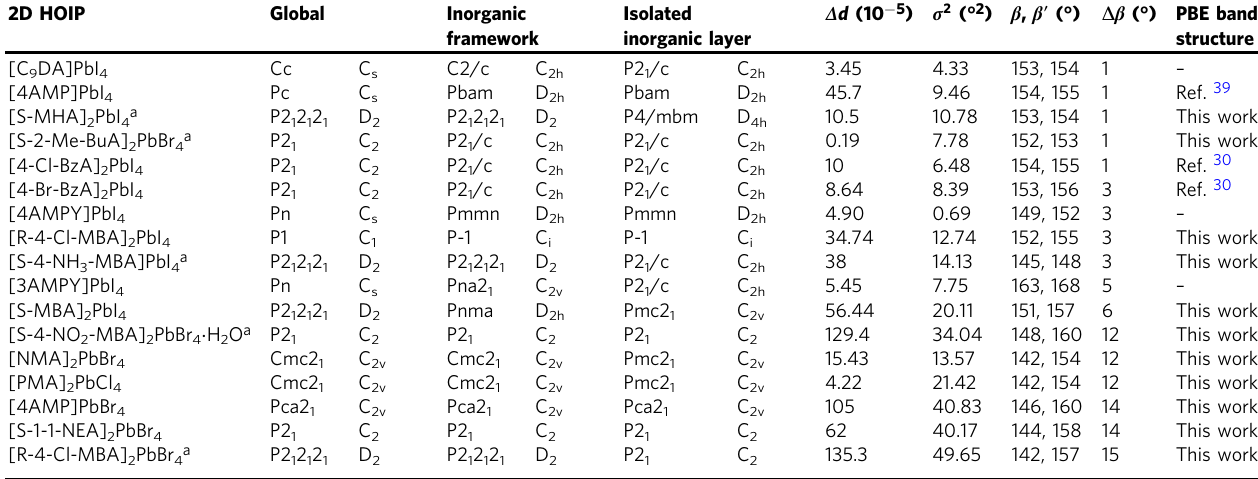
MHPs are sorted based on Δ β values along one of the in-plane directions (see Fig. 2f, g), which correlate strongly with the spin-splitting magnitude as shown in Fig. 5. a New chiral MHPs reported in this